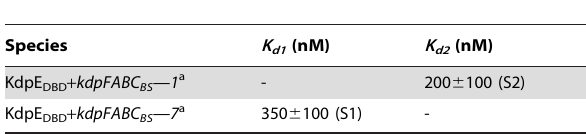
Table 3. Binding affinities of KdpE DBD to wild-type and mutant DNA molecules determined by Sedimentation Equilibrium